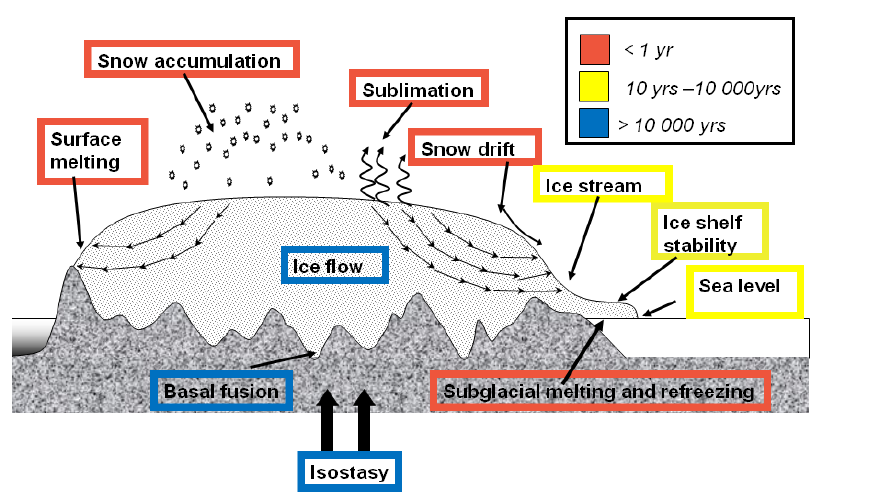
Figure 2. Ice sheet mechanisms and time-scale outline adapted from [7]. Surface melting, snow precipitation, sublimation, wind-driven sublimation and basal melting or refreezing are assumed to instantaneously react to climate change. Ice streams, outlet glaciers are assumed to react quickly (between 1 yr to 10 yr) or slowly as ice-shelf dynamics to climate change (meaning between 100 and 1,000 yr). On the contrary, ice flow, basal temperature and fusion isostasy take a very long time to react (time lag is between 10,000 and 100,000